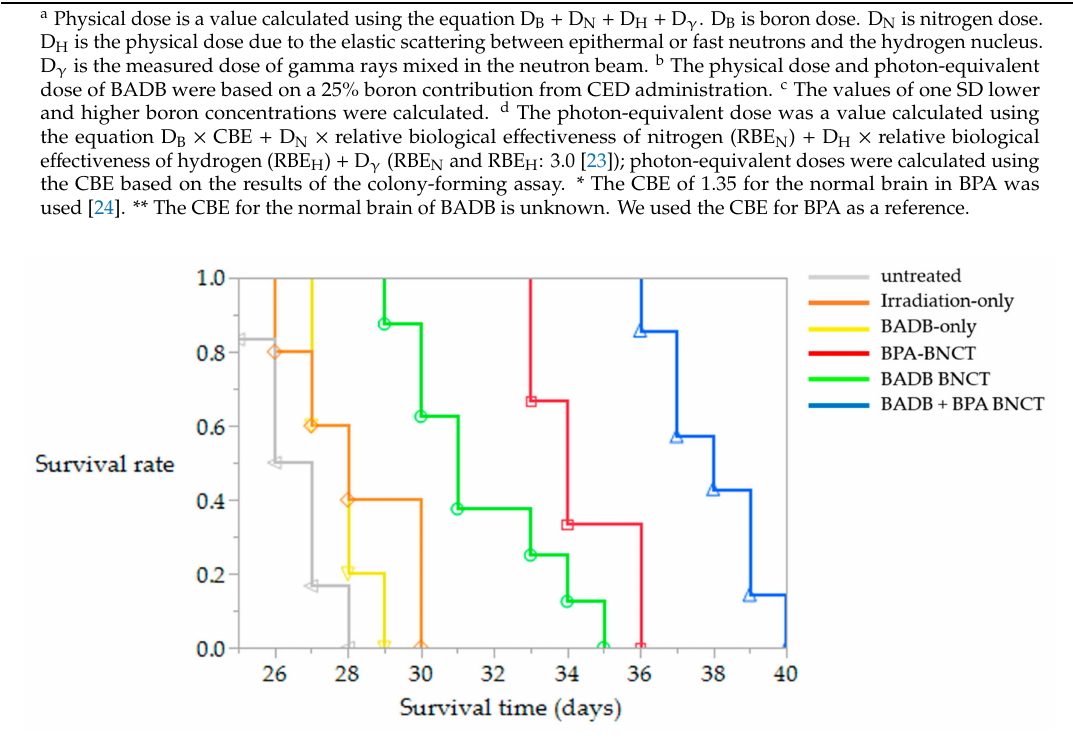
Figure 5. Kaplan–Meier survival curves of F98 glioma-bearing rats after neutron irradiation. Survivaltimesindaysaftertumorimplantationwereplottedforthefollowinggroups: untreatedcontrols (gray line), neutron irradiation-only (yellow line), BADB-only (orange line), BPA boron neutron capture therapy (BNCT) (red line), BADB BNCT (green line), and the combination of BADB and BPA BNCT (blue line). Table 3. Survival times of F98 glioma-bearing rats after neutron